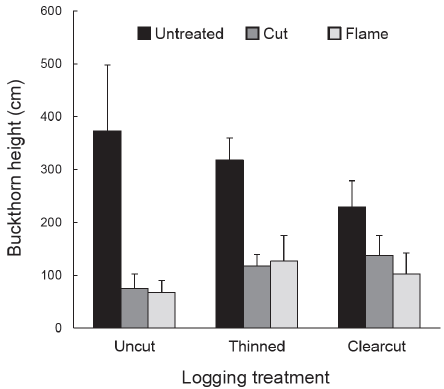
Figure 2. Height (cm) of glossy buckthorn (tallest individual per 8 m 2 plot) in relation to logging treatment (uncut control, thinned, clearcut) and buckthorn treatment (untreated, cut, flame) at MacDonald Lot, Durham, NH, USA, in 2012, the third year after logging. n = 27 subplots.